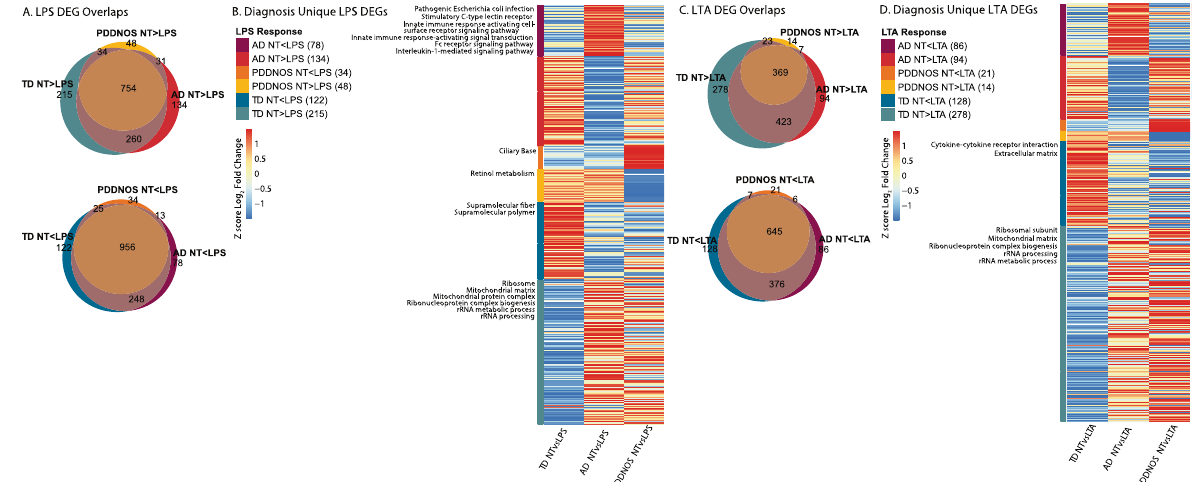
Fig. 2 Differentially expressed genes unique to diagnosis conditions. A Euler plots showing the overlap among DEGs identi fi ed as upregulated or downregulated in response to LPS for each diagnosis. B Heatmap of Z-score Log2 Fold Change values for unique LPS DEGs that were signi fi cantly regulated in only AD, PDDNOS, or TD (non-overlapping regions of the Euler plots in A) with signi fi cantly enriched GO terms and KEGG pathways aligned to heatmap. See Table S6 for full lists. C Euler plots showing the overlap among DEGs identi fi ed as upregulated or downregulated in response to LTA for each diagnosis. D Heatmap of Z-score Log2 Fold Change values for unique LTA DEGs that were signi fi cantly regulated in only AD, PDDNOS or TD (non-overlapping regions of the Euler plots in C ), with signi fi cantly enriched GO terms and KEGG pathways aligned to heatmap. See Table S7 for full lists. AD: autistic disorder, TD: typical developing controls, PDD/NOS: pervasive development disorder not otherwise speci fi ed, NT: no treatment, LPS: lipopolysaccharide, LTA: lipoteichoic